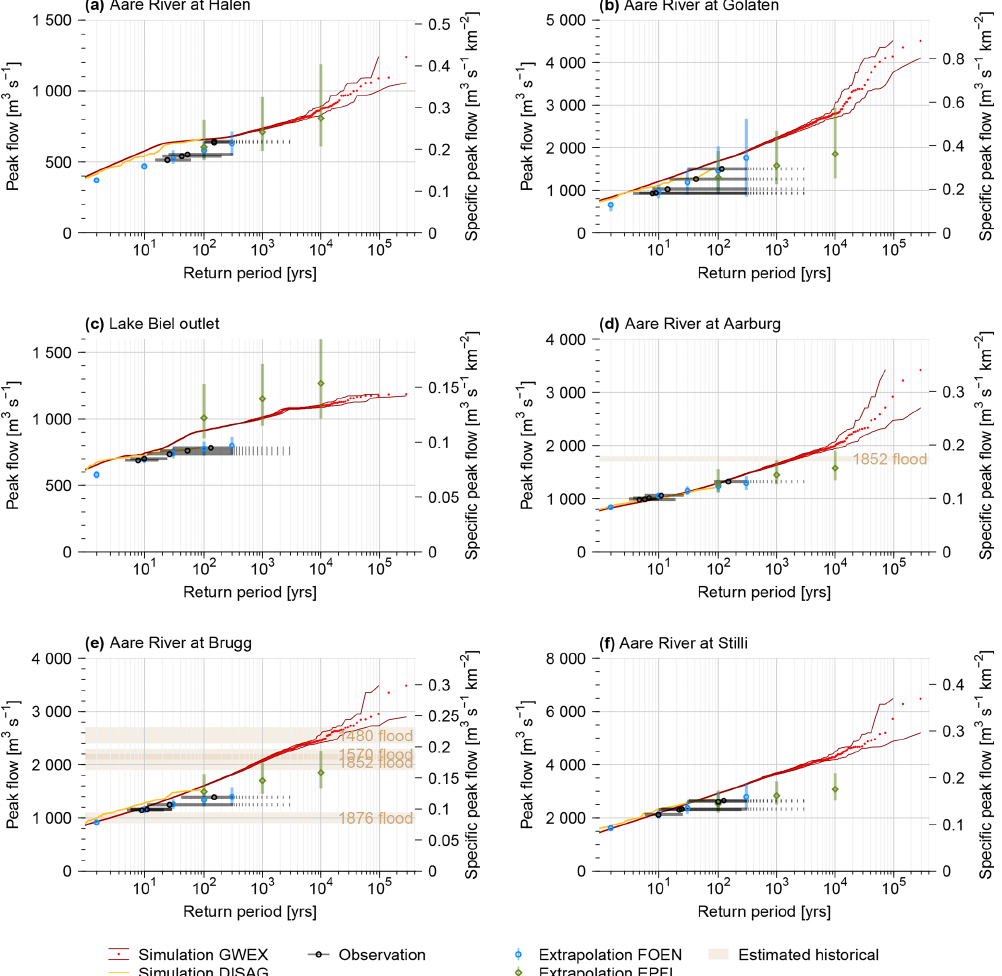
Figure 7. Exceedance curves for selected sites along the Aare River: Halen, Golaten (downstream of the confluence with the Saane River), the outlet of Lake Biel (close to Brügg–Aegerten), Aarburg (downstream of the confluence with the Emme River), Brugg (upstream of the confluence with the Reuss and Limmat rivers) and Stilli (downstream of the confluence with the Reuss and Limmat rivers). Red: AMFs for CS (median representative parameter set) based on 289000 years of GWEX weather scenarios, with the central 95% confidence interval computed according to Loucks and van Beek (2017); orange: simulated AMFs (median representative parameter set) on the basis of 85 years of disaggregated weather observations (DISAG); black: five highest observed peak flows plotted at return periods according to FOEN with confidence interval (Baumgartner et al., 2013) (confidence intervals that are unbounded towards high return periods are dashed); blue: extrap- olation of observed peak flow records according to FOEN with confidence interval (Baumgartner et al., 2013); green: regionally enhanced extrapolation of observed peak flow records according to EPFL with confidence interval (Asadi et al., 2018); light brown (for Brugg and Aarburg only): range of reconstructed historical floods (Baer and Schwab, 2020). Observation and reconstruction sites do not always match simulation sites exactly; the corresponding values have been scaled where necessary, assuming constant discharge per unit